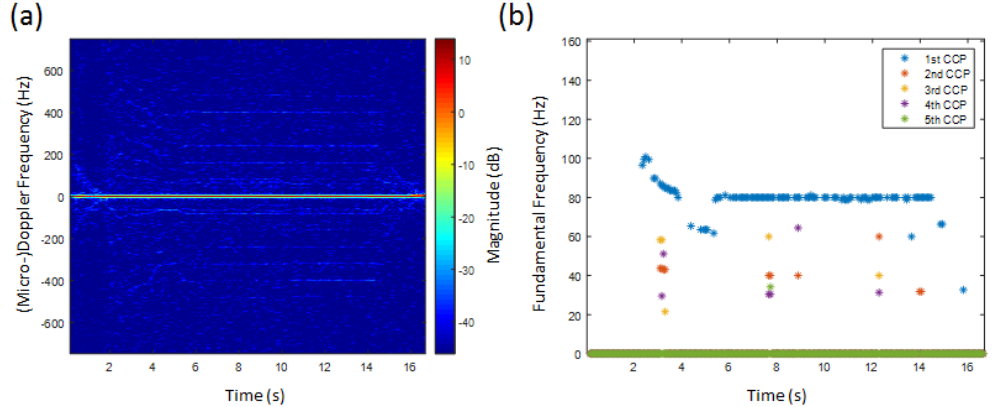
Figure 6. ( a ) HERM lines spectrogram for one-propeller helicopter measured by C-band radar; ( b ) corresponding multi-frequency detector result.